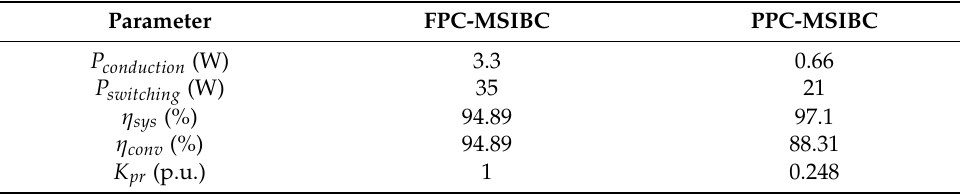
Table 6. Power losses, efficiency, and K pr results of the double-inductor topology. Parameter